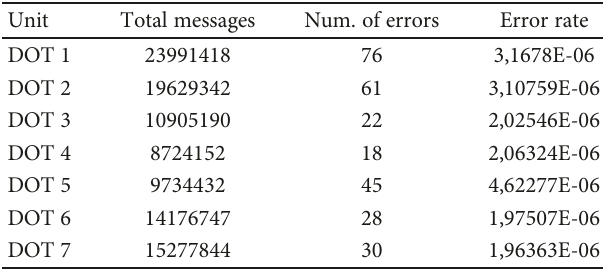
Table 7: Total number of messages vs. erroneous